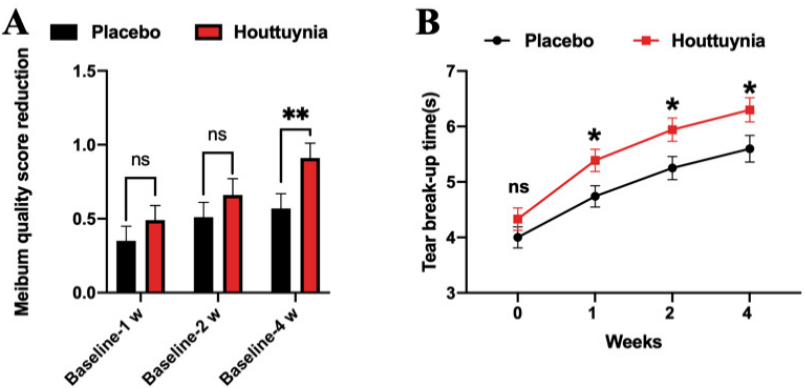
Figure 3. Change in meibum quality and tear break-up time. ( A ) shows the meibum quality score reduction values after one week, two weeks, and four weeks compared with the baseline. ( B ) shows tear break-up time at baseline, one week, two weeks, and four weeks. Data are presented as mean ± SEM. * p < 0.05, ** p < 0.01, ns, no significance.